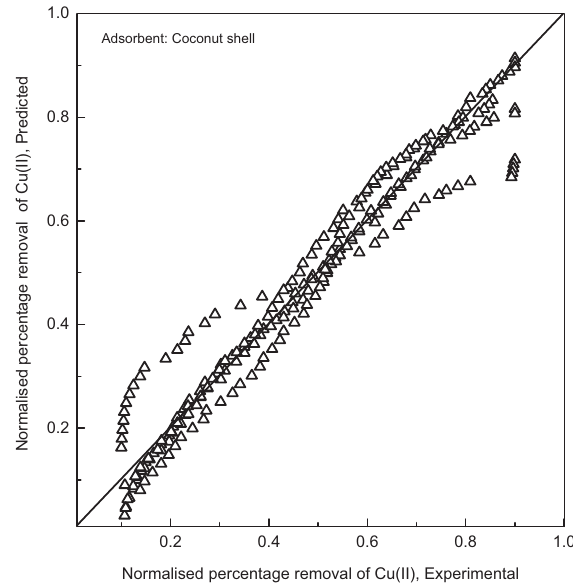
Figure 8. Regression analysis comparison curve with coconut shell as adsorbent